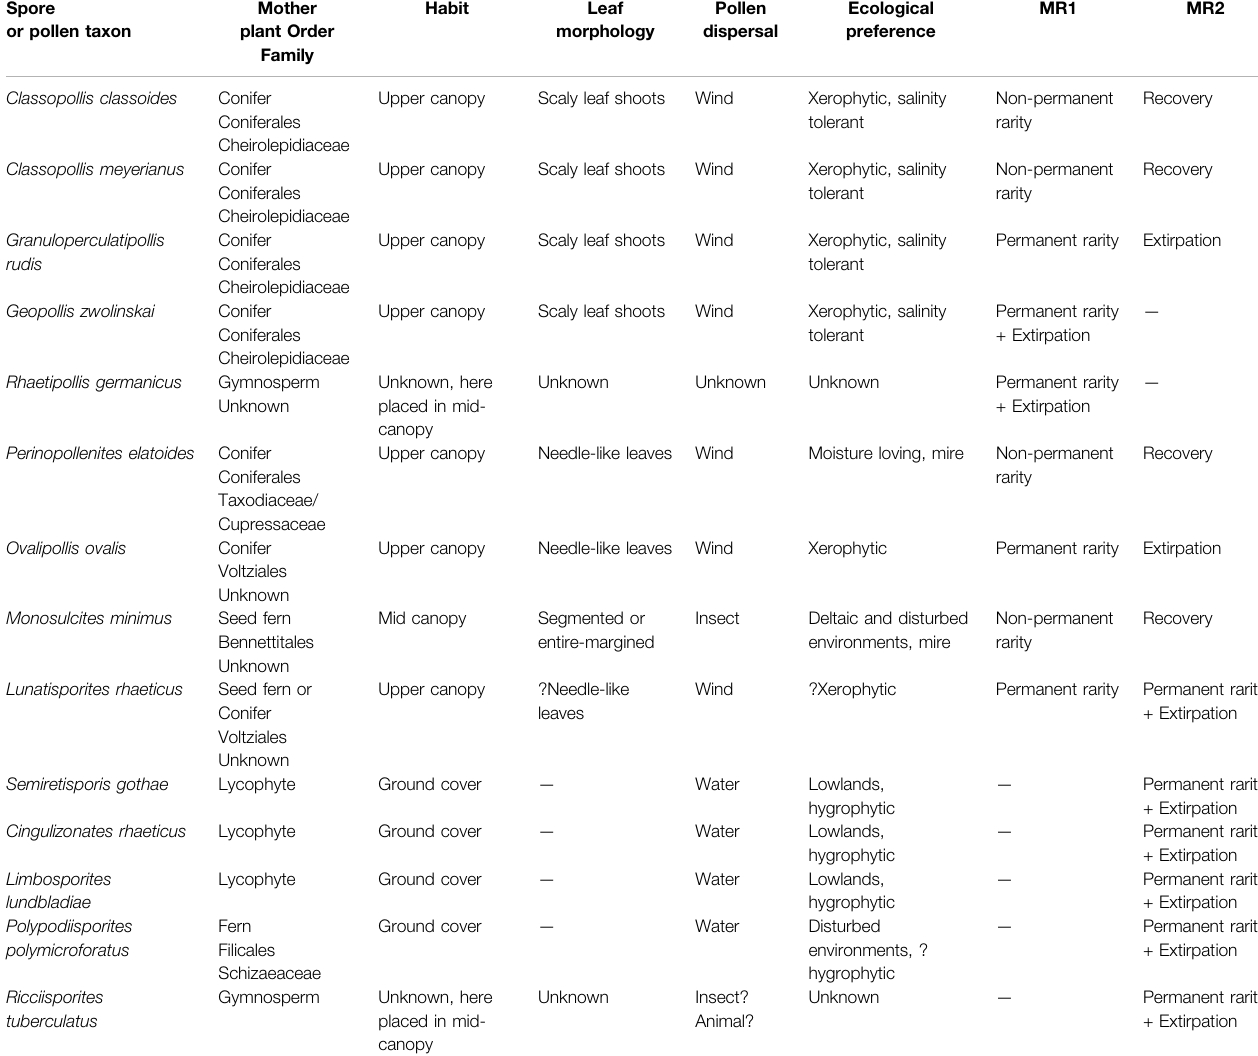
TABLE 1 | Botanical af fi nity, habit, leaf morphology, pollination strategy, and environmental preferences for the parent plants affected at MR1 and MR2. Spore or pollen